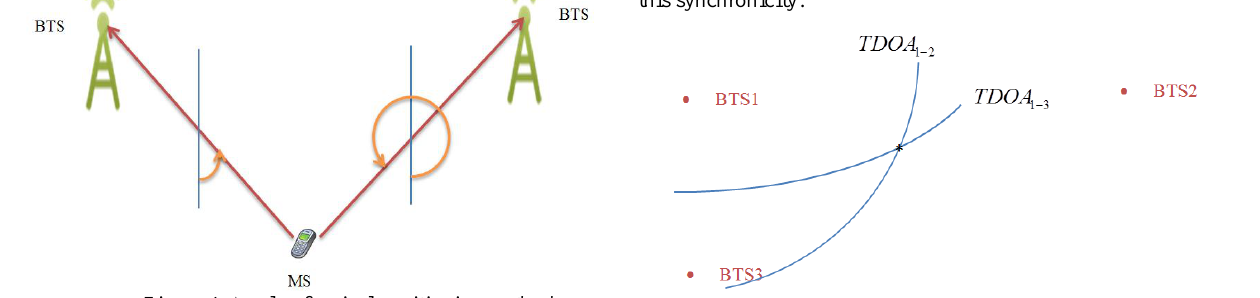
Figure 5. Time Difference of Arrival Method